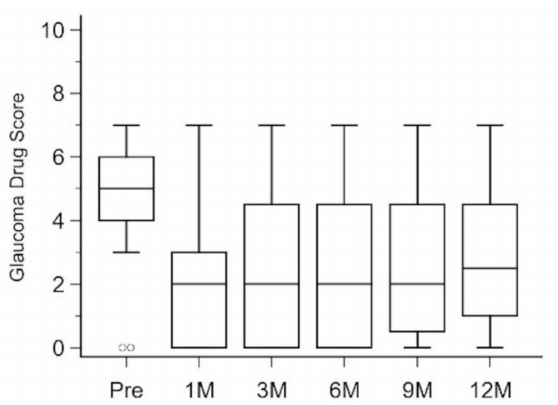
Figure 4. Box and whisker plots of glaucoma drug score at different time points. Pre, pre-operatively; 1 M, 1 month post-operatively; 3 M, 3 months post-operatively; 6 M, 6 months post-operatively; 9 M, 9 months post-operatively; 12 M, 12 months